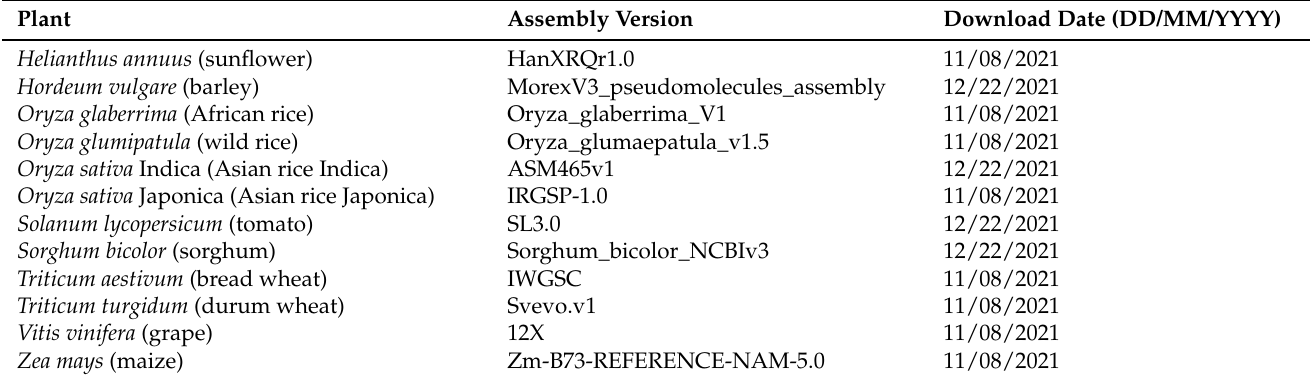
Table 1. Assembly versions of the input data from Ensembl Plants including reference genome, SNP catalog and gene